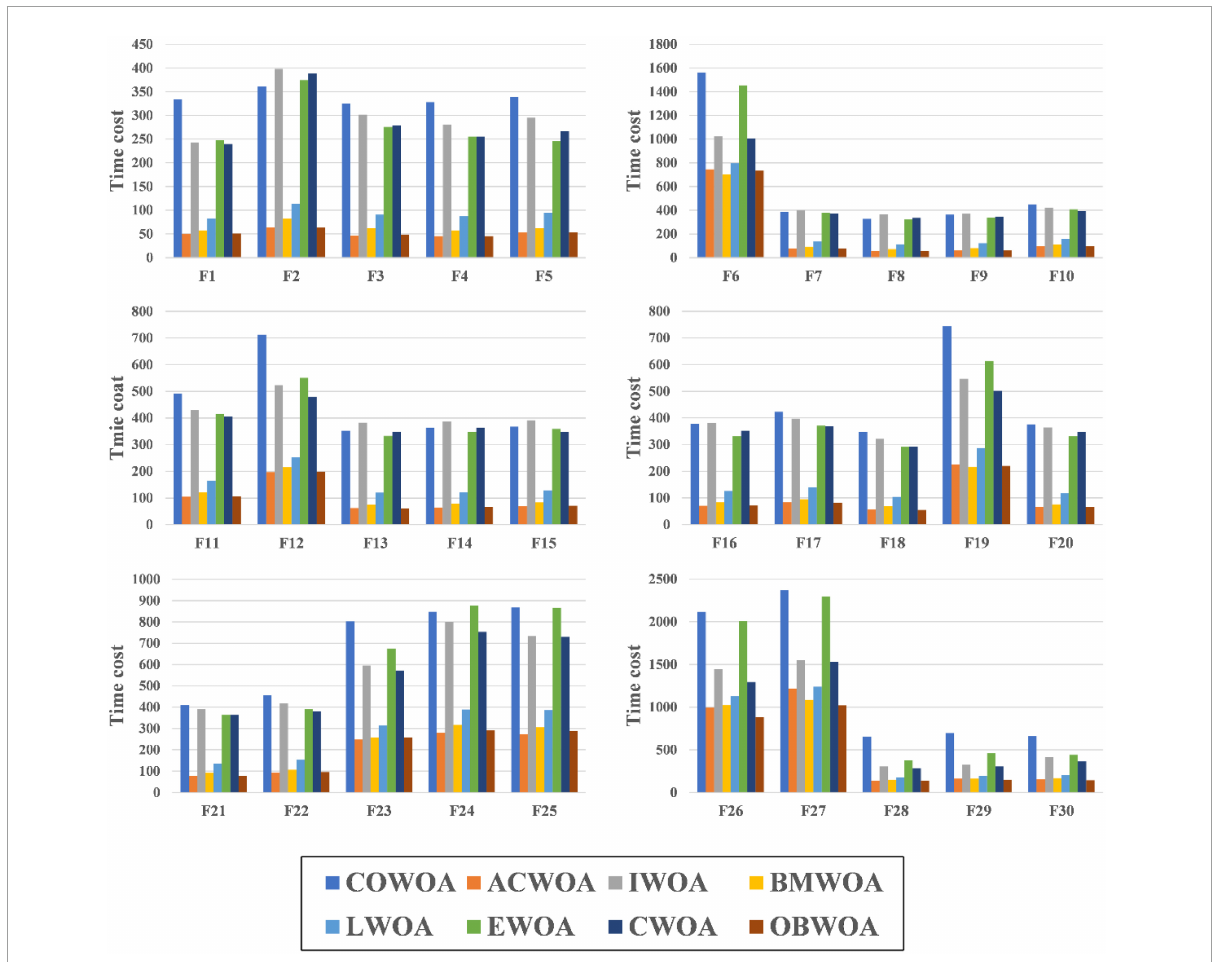
FIGURE9 The computational cost of COWOA with the WOA variants.